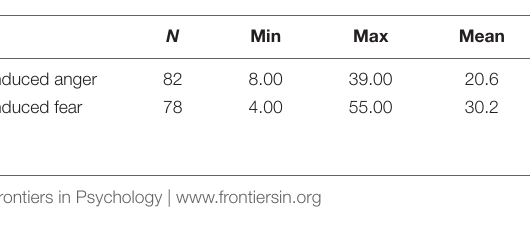
TABLE 3 | Description of induced emotions